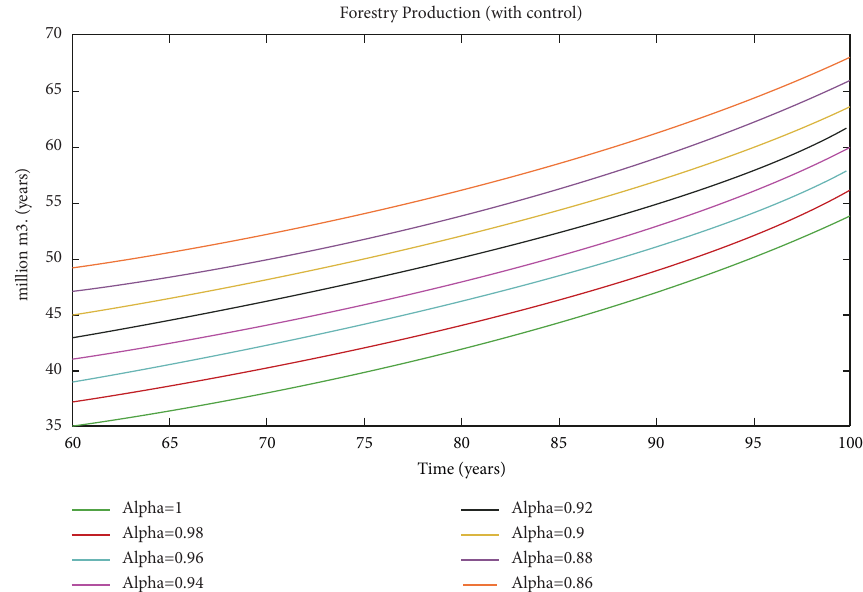
Figure 11: Comparison of the forestation rate with control with diferent values of alpha.